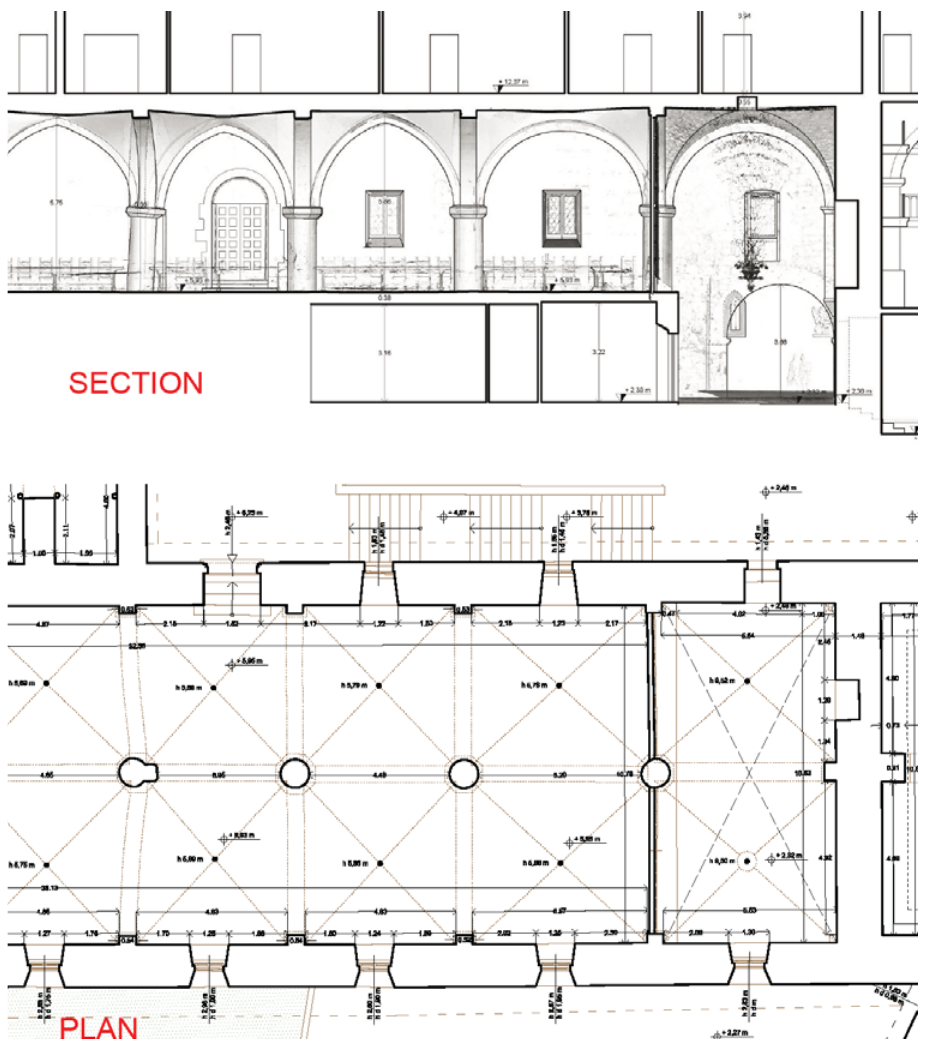
Figure 5a, b. Refectory: Longitudinal Section and